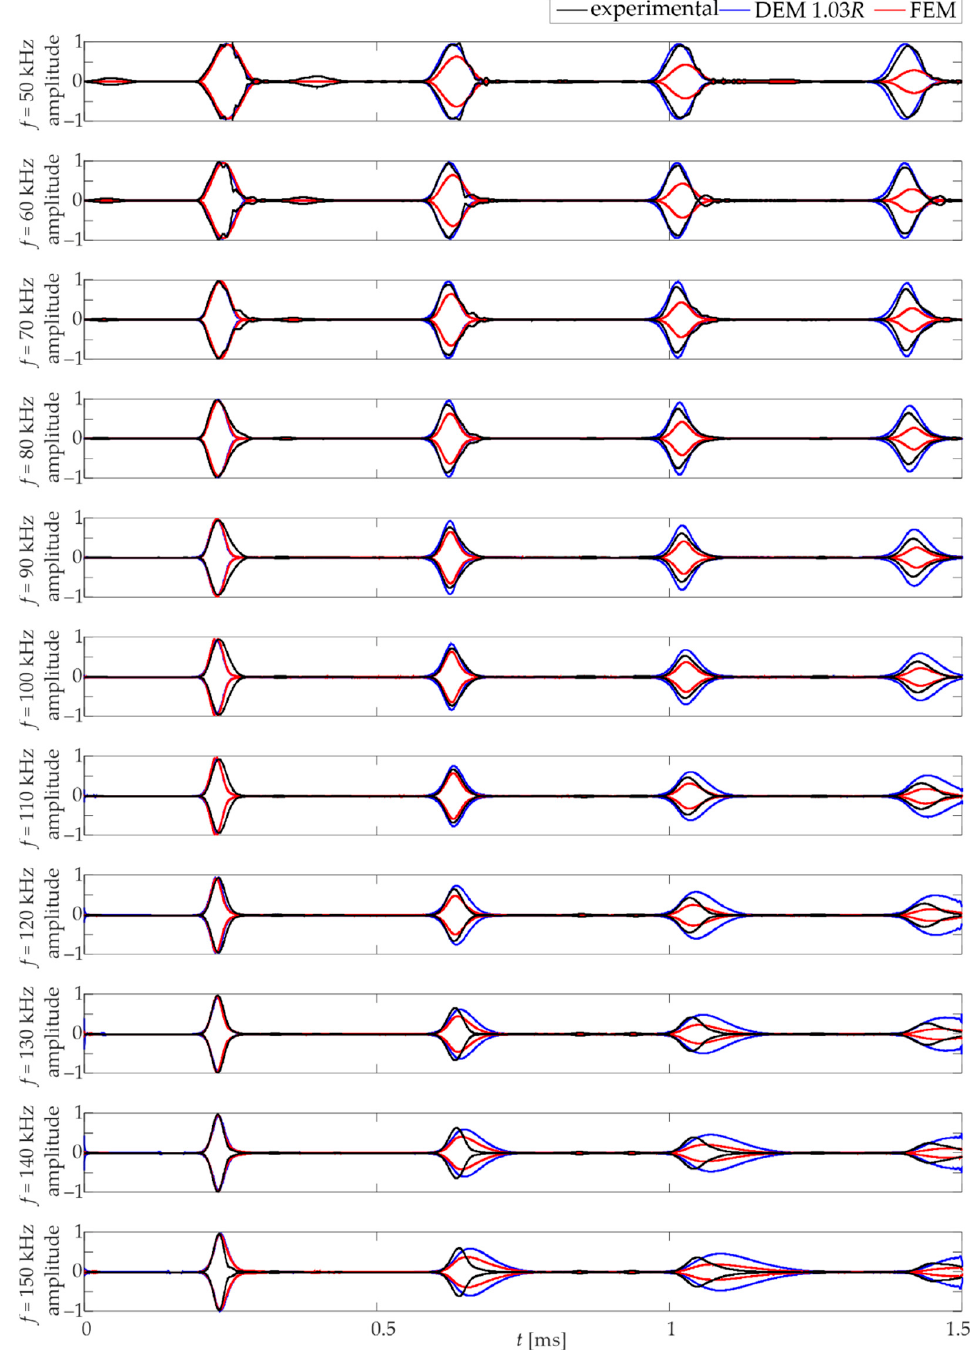
Figure 10. Comparison of wave propagation for experimental and numerical FEM/DEM results.